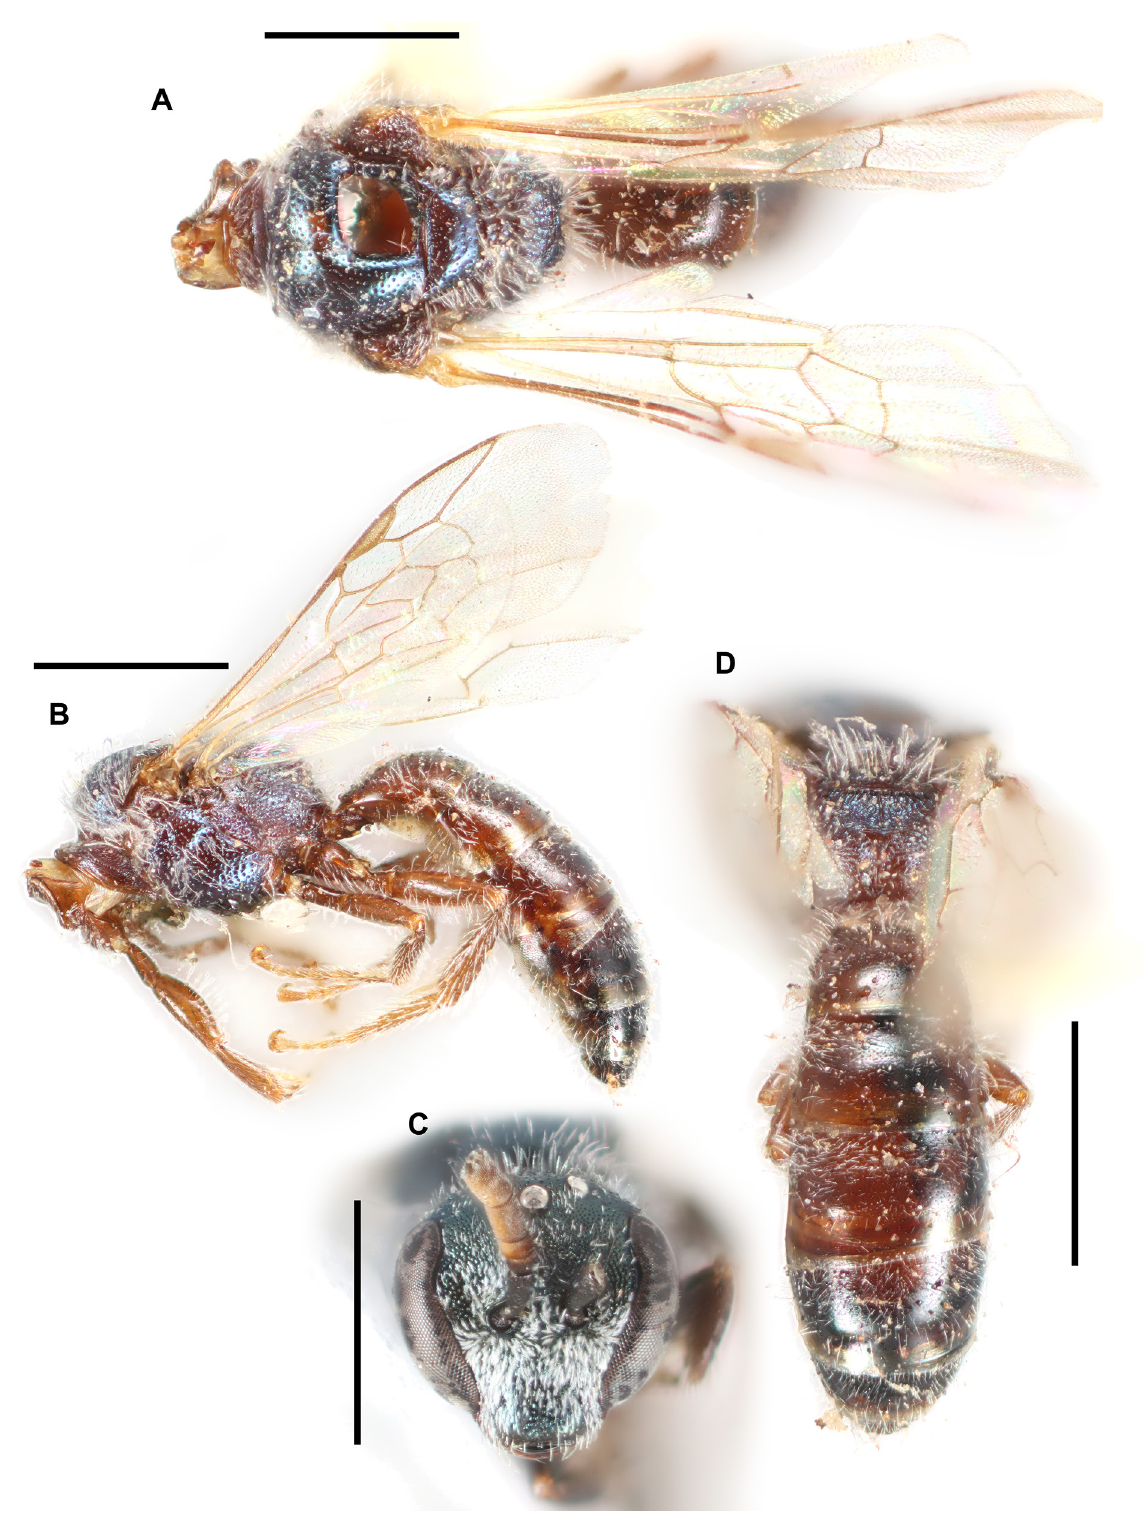
Fig. 64. Lasioglossum ( D .) stictaspis (Sandhouse, 1923), ♂, holotype (USNM) (except C, which is a Colorado specimen) (reproduced from Gardner & Gibbs 2022). A . Dorsal habitus. B . Lateral habitus. C . Face. D . Metasoma and propodeum. Scale bars = 1